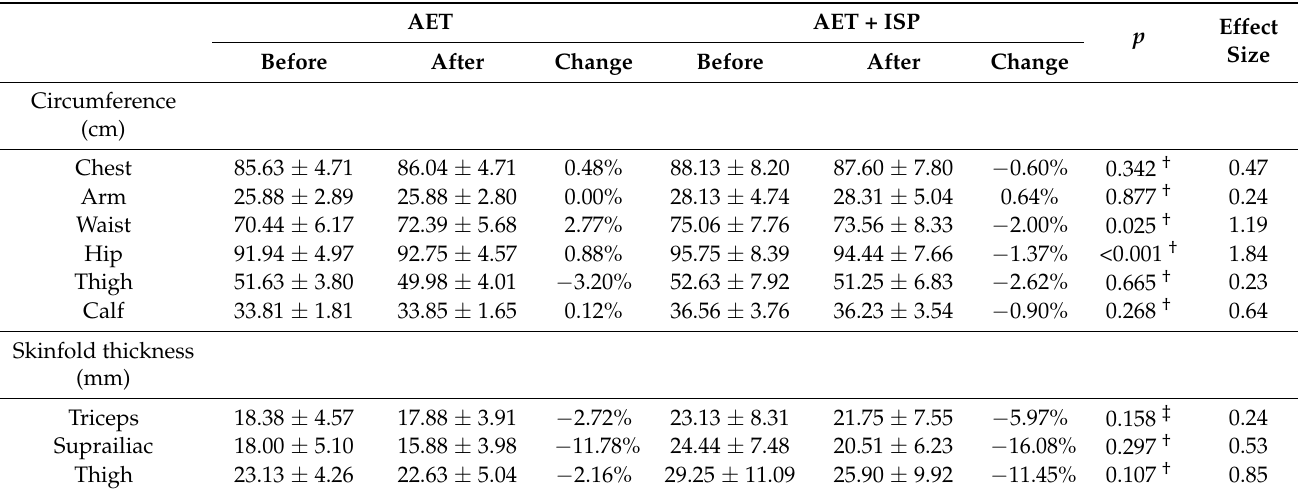
Table 4. The anthropometric characteristics of AET and AET + ISP groups before and after 8 weeks of intervention. AET AET + ISP